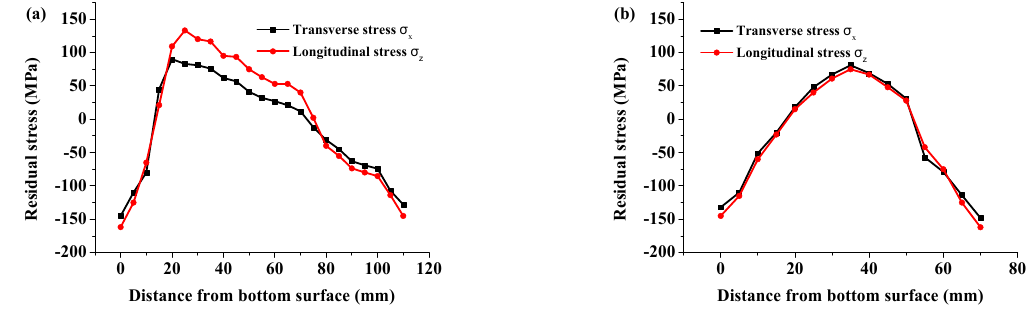
Figure 9. Residual stress distribution of cold pressed T-type rib: ( a ) path ab; ( b ) path cd (depicted in Figure 3).